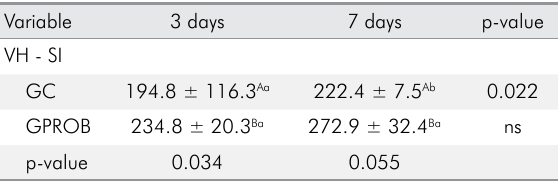
Table 2. Mean and standard deviation (μm) of villus height (VH) of the small intestine (SI), with intra- and intergroup comparisons (n =